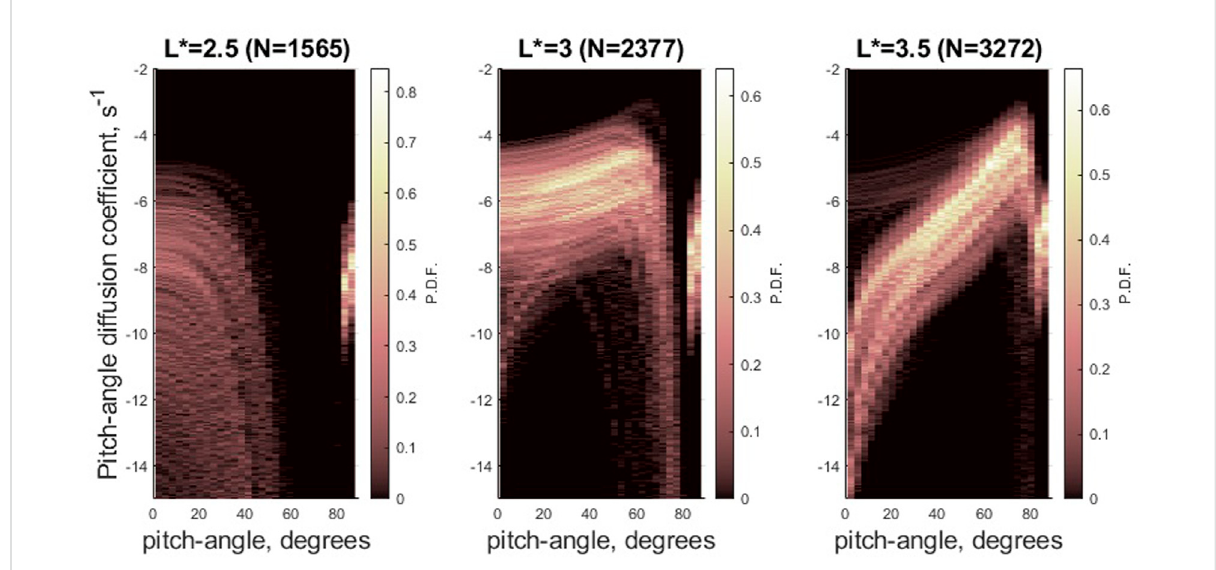
Probability distribution functions for D αα ( α ) in each of the 3 L * bins used in this numerical study. The number of individual observation-speci fi c D αα ( α ) in each distribution N is indicated at the top of each panel. See (Watt et al., 2019) for choices made during construction of observation- speci fi c D αα .